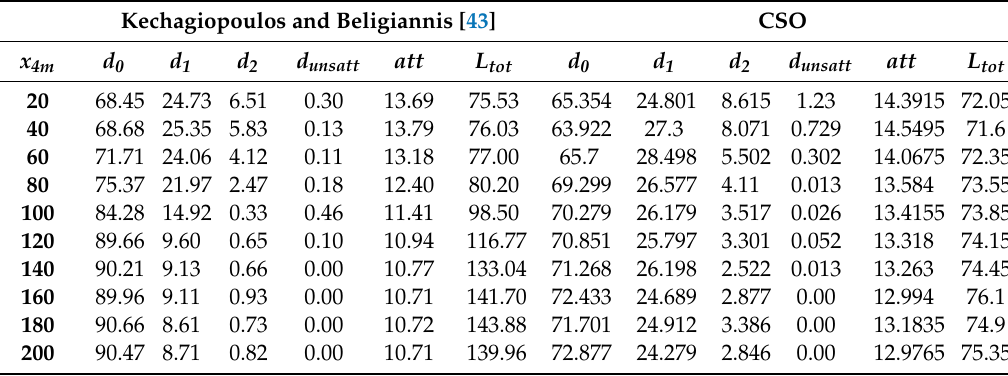
Table 17. Comparative results for providers’ operational cost for a route set with four routes and eight nodes per route (average values).